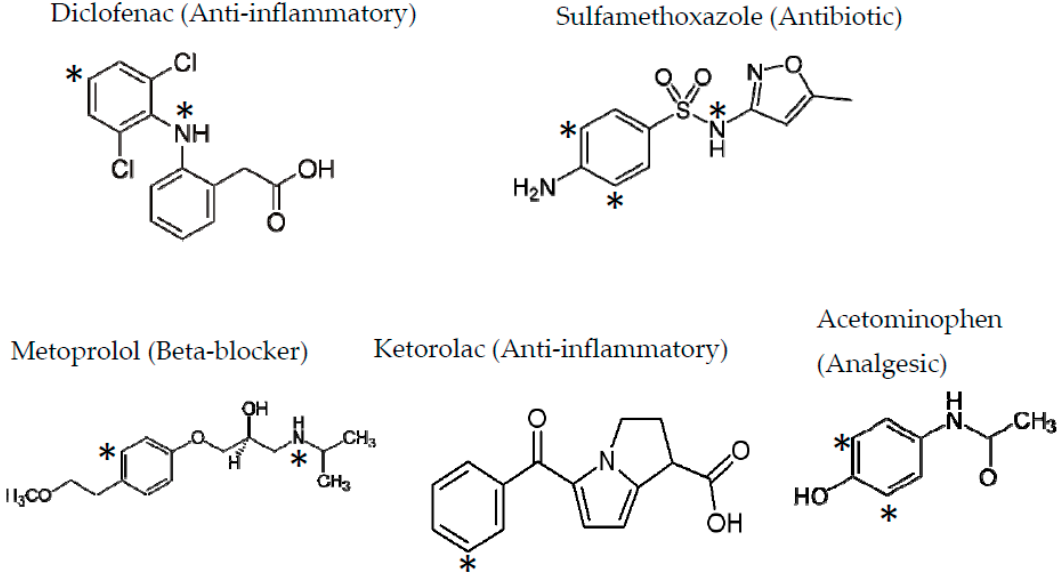
Figure 2. Examples of molecular structures of some pharmaceuticals usually found in urban wastewater. * Possible points of ozone attack.